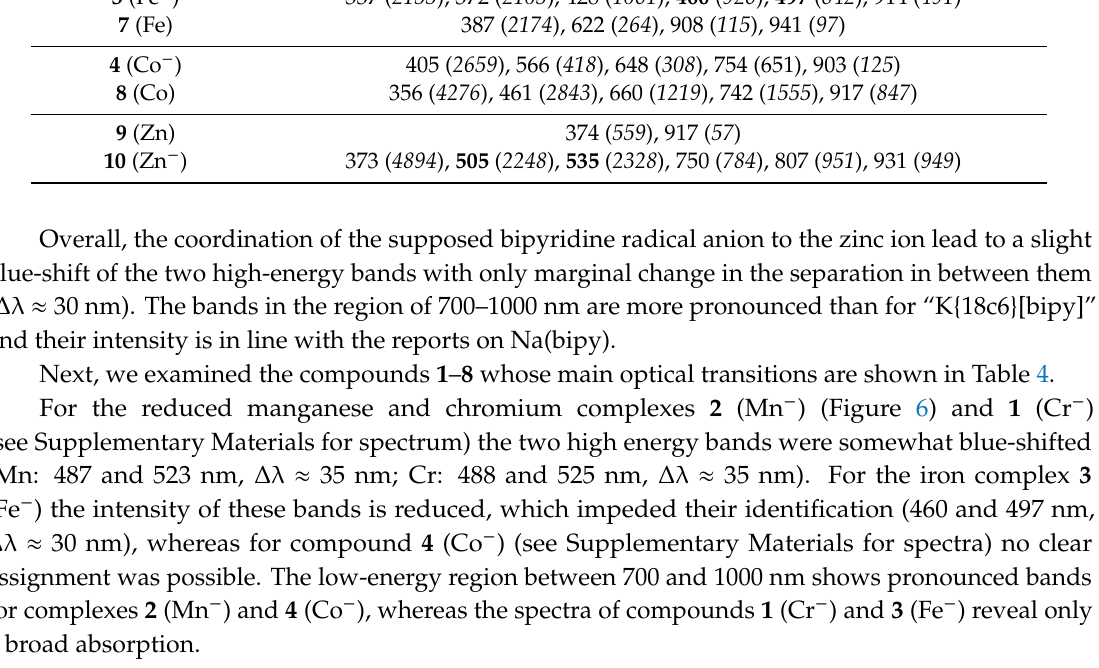
Table 4. UV/Vis spectroscopic features of complexes 1 – 10 in Et 2 O. Bold numbers highlight the two optical bands attributed to the π  π *-based transition of the reduced bipyridine ligand.